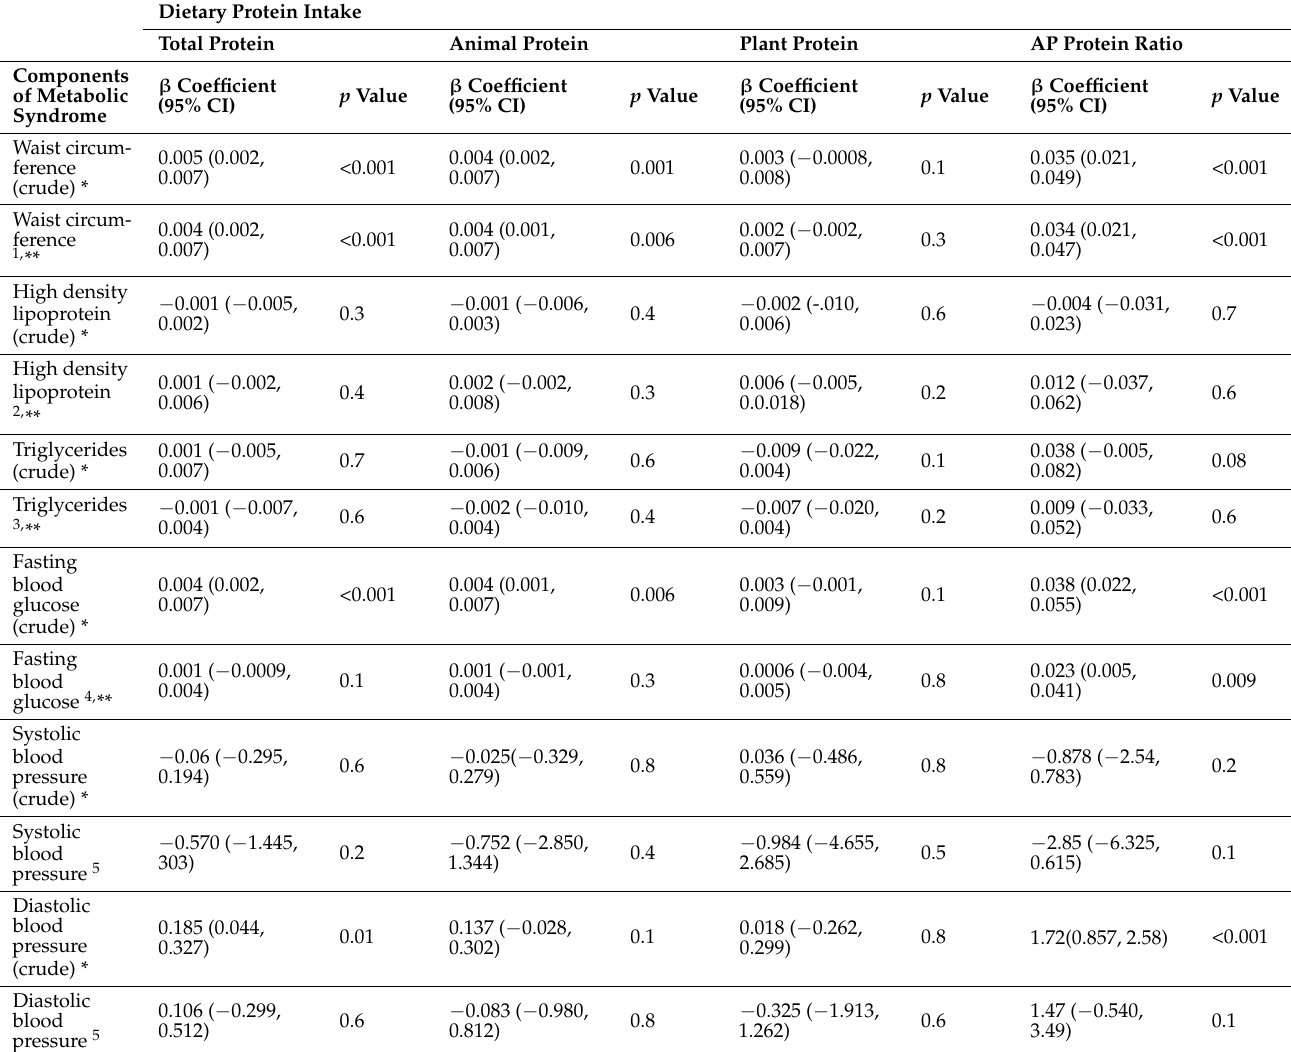
Table 3. Association between dietary protein intake and components of metabolic syndrome in AHS-2 calibration study. ( n =